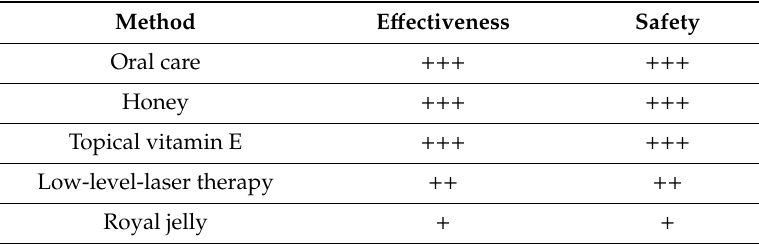
Table 6. Suggestions regarding treatment of radiation-induced oral